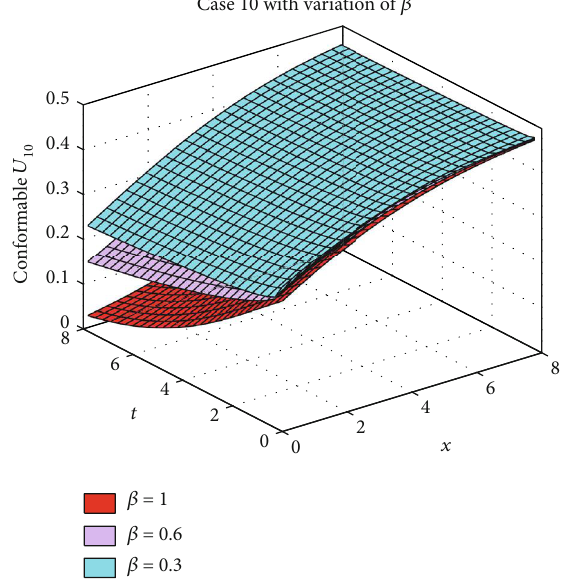
Figure 5: Conformable fractional FHN equation (Case 10) considering γ = 1 , ξ = 0 : 45 , β = 1 , β = 0 : 6 , and β = 0 : 3